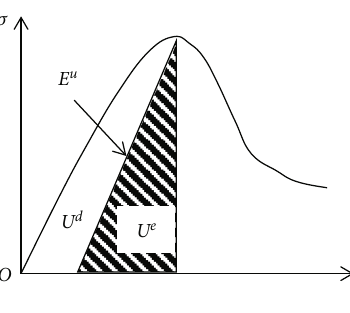
Figure 2: Energy calculation